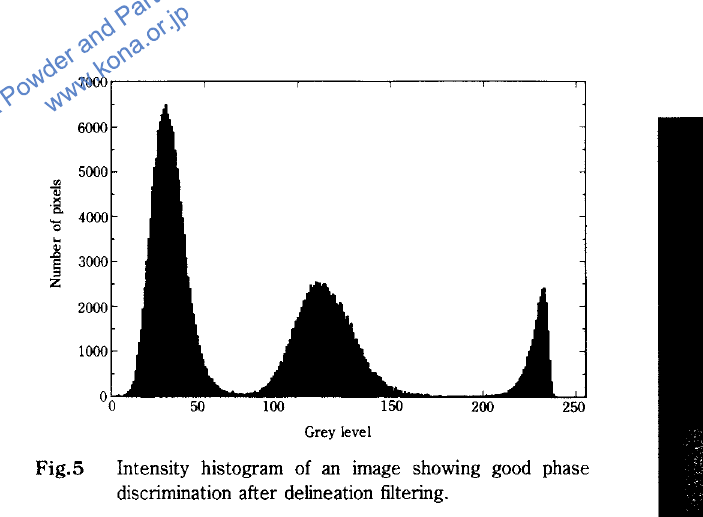
Intensity histogram of an image showing good phase discrimination after delineation filtering.